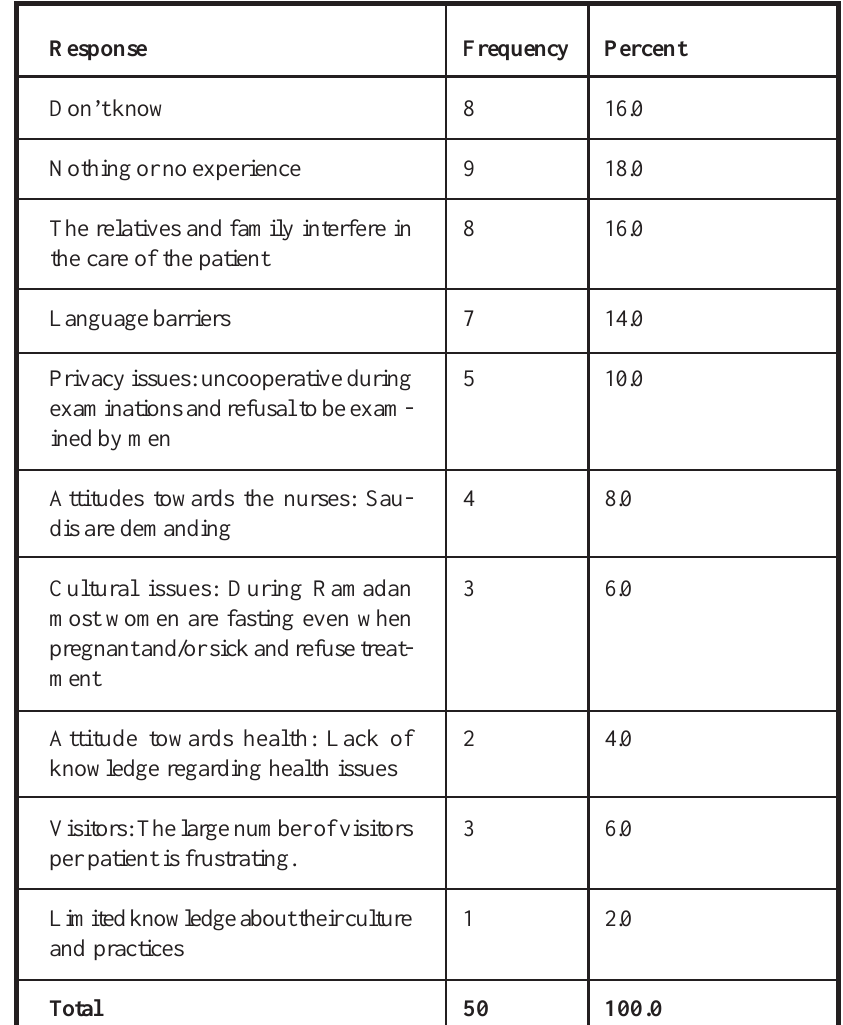
Table 2 Challenges encountered when caring for Saudi